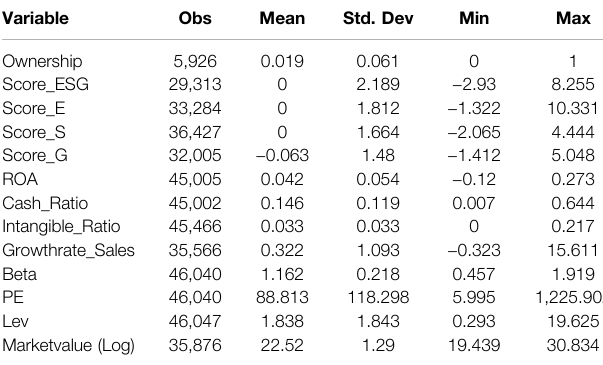
TABLE 2 | Descriptive